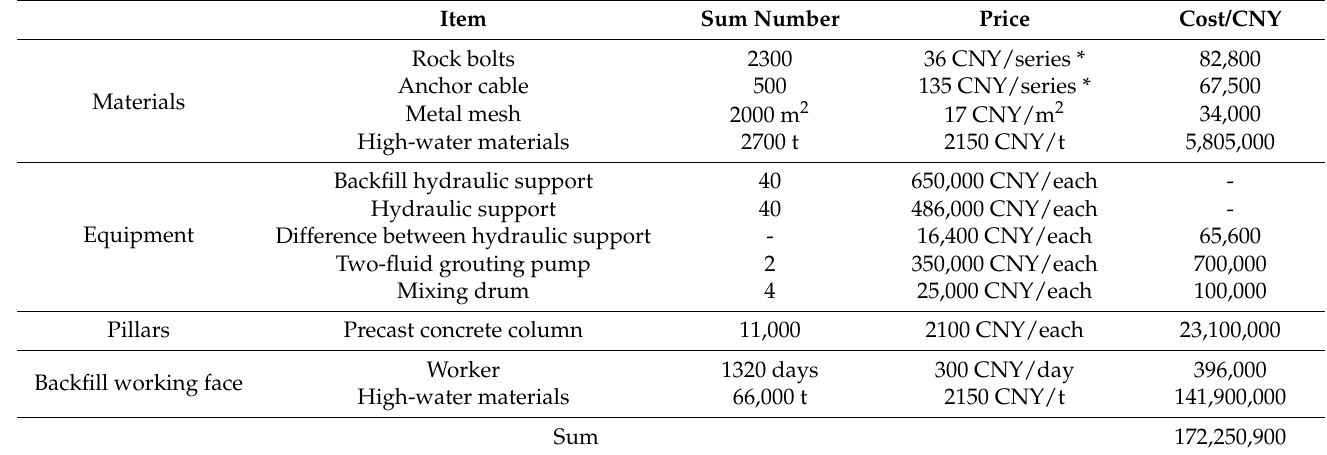
Table 7. The cost of using the structure backfill